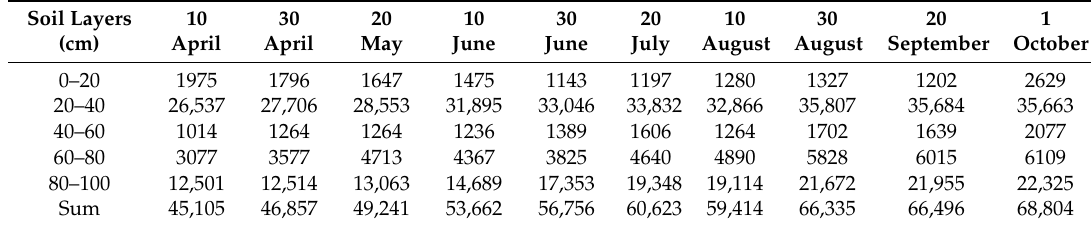
Table 10. Salt-storage changes at Site A2 in di ff erent periods (kg hm − 2